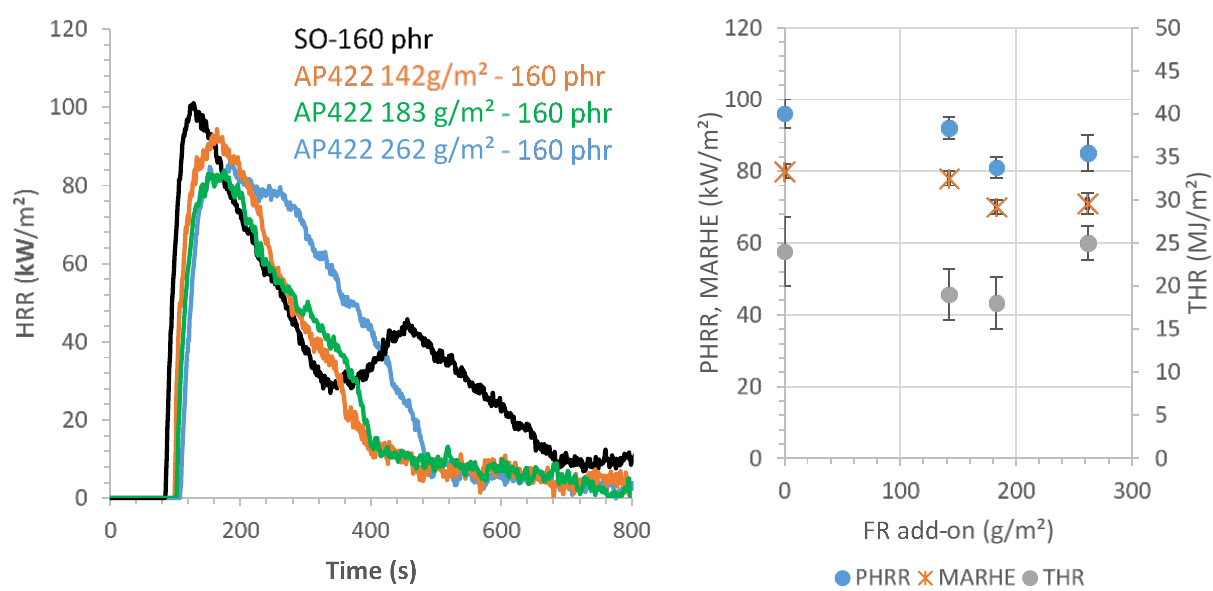
Figure 8. HRR curves of composites made using AP422-treated SORIC with different add-ons and evolution of some of the cone parameters versus the FR add-on.